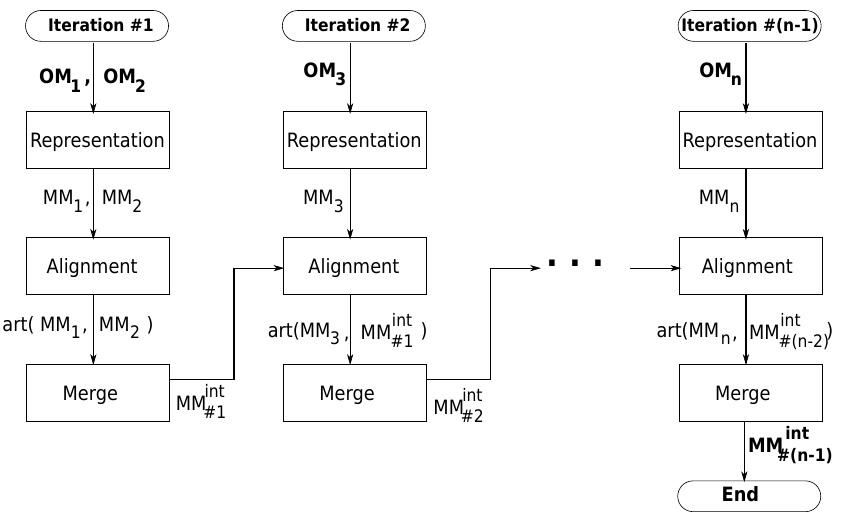
Figure 1. General conceptual integration